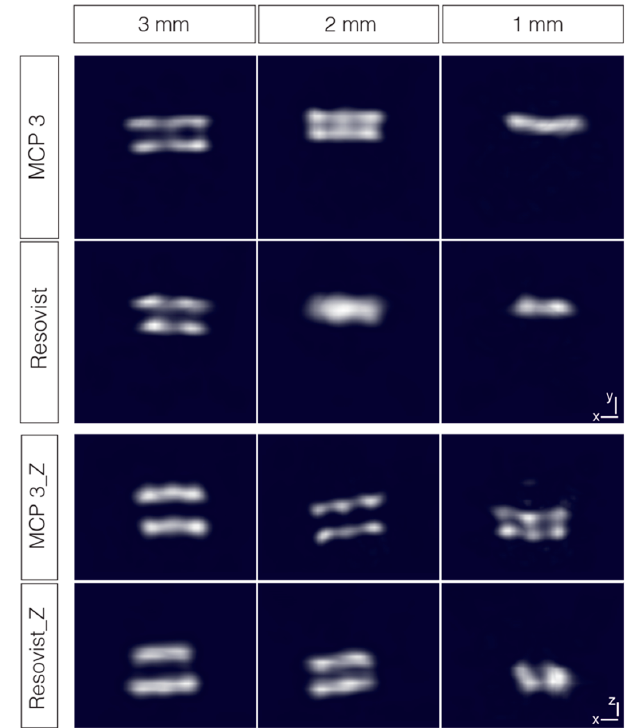
Figure 11. Dual-tube phantoms of 3, 2, and 1 mm inner diameter, filled with 1 mmol Fe/l MCP 3 and Resovist ® and measured in two orientations. Images are interpolated and represented as maximum intensity projections with the threshold set at 50%. intensity projections with the threshold set at